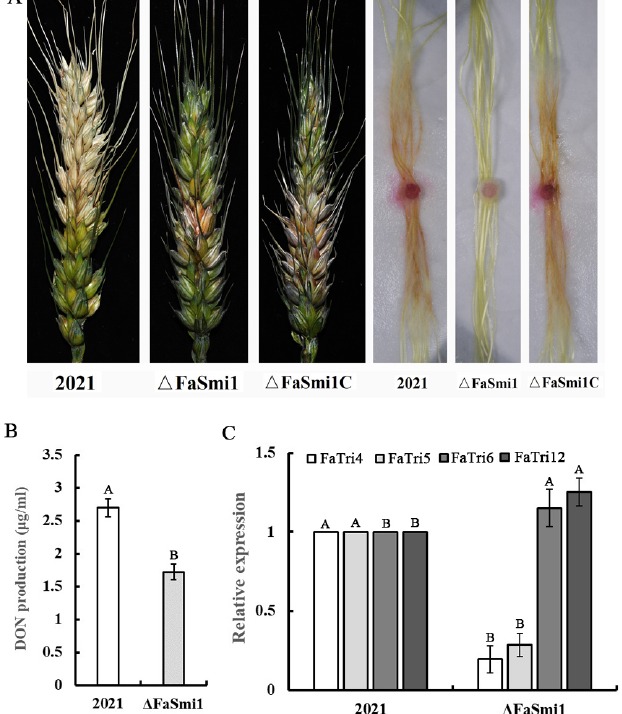
Figure 5. Effects of FaSmi1 on virulence and DON production of F. asiaticum . ( A ) Development of symptoms on flowering wheat heads and corn stigmas. Wheat heads were photographed after 2 weeks inoculated with a conidial suspension. Corn stigmas on filter papers were inoculated with brick-shaped mycelial plugs, and their pathogenic performance was examined after 3 days. ( B ) DON production of 2021 and ∆ FaSmi1 were measured after incubation in LTB for 7 days. Line bars in each column denote standard errors of three repeated experiments. Values on the bars followed by the same letter are not significantly different at p = 0.05. ( C ) The expression level of DON production- associated genes FaTri4 , FaTir5 , FaTri6 and FaTri12 were analyzed in 2021 and ∆ FaSmi1 after incubation in LTB for 2 days. Line bars in each column denote standard errors of three repeated experiments. Values on the bars followed by the same letter are not significantly different at p =